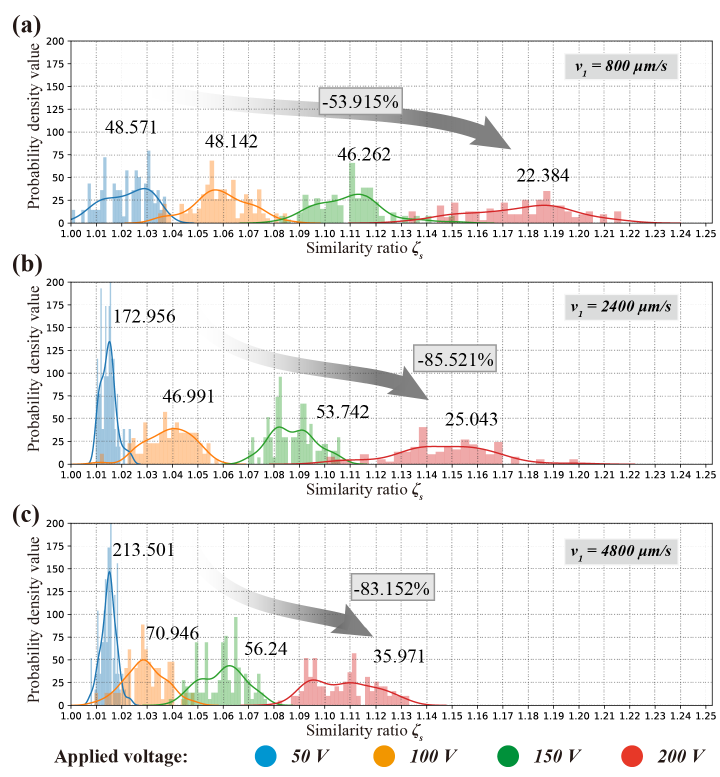
Figure 12. Probability density value of similarity ratio ζ s with different nozzle speed: ( a ) v 1 = 800 µ m/s; ( b ) v 2 = 2400 µ m/s; ( c ) v 3 = 4800 µ